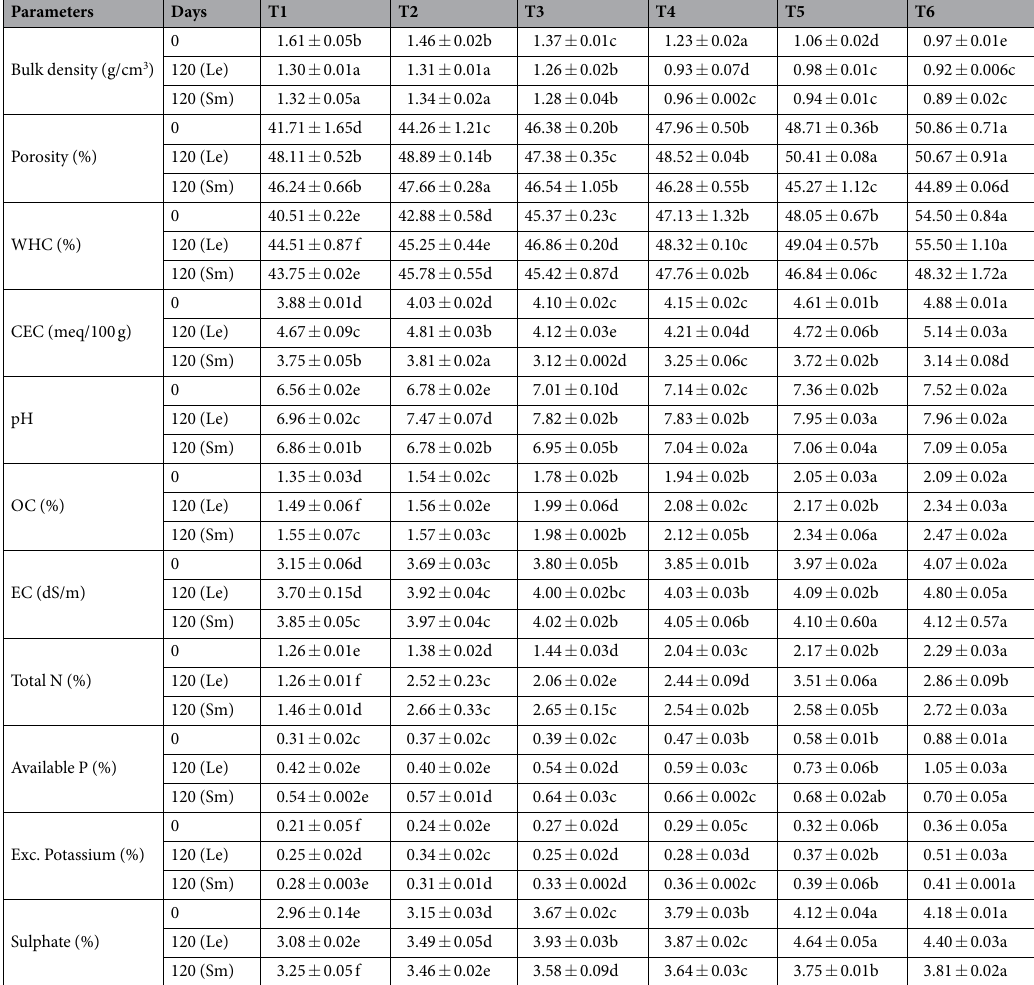
Table 1. Physico-chemical properties of vermicomposted fly ash amended soil at the time of sowing and harvesting of Lycopersicon esculentum and Solanum melongena . Le: Lycopersicon esculentum ; Sm: Solanum melongena . Values are in Mean ± SD; (n = 3). Different letters in the same row represent significant differences in the physico-chemical parameters of different treatments comprising L. esculentum and S. melongena at p < 0.05 according to Duncan’s Multiple Range Test (One-way ANOVA followed by Tukey’s